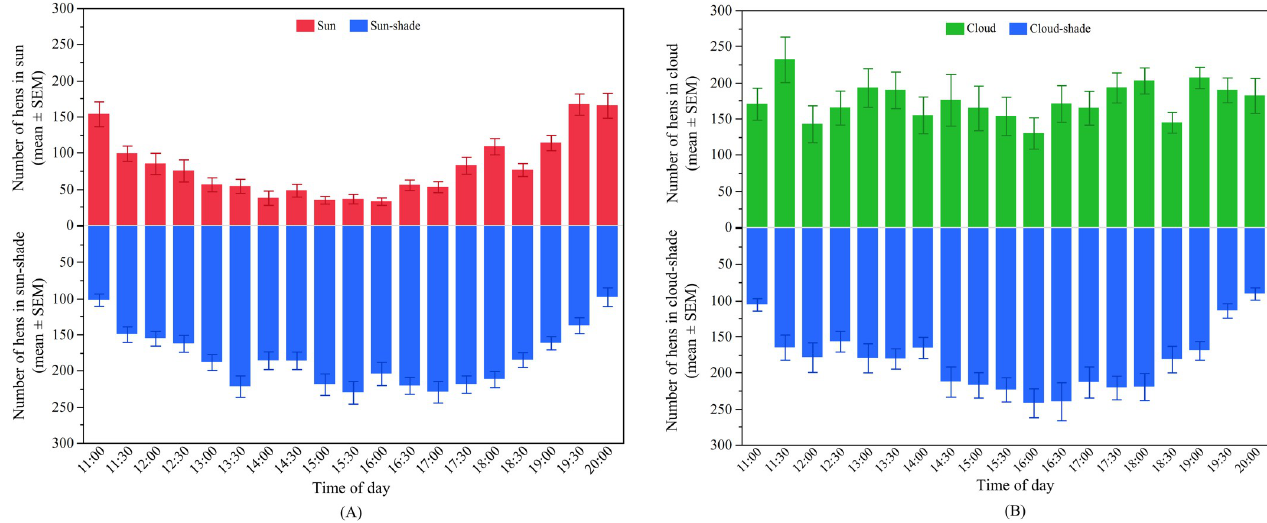
Fig 2. Distribution of hens on the range across the day in TAS: (A) The mean ( ± SEM) number of hens in the ‘sun’ (top) and ‘sun-shade’ (bottom); (B) The mean ( ± SEM) number of hens in the ‘cloud’ (top) and ‘cloud-shade’ (bottom).